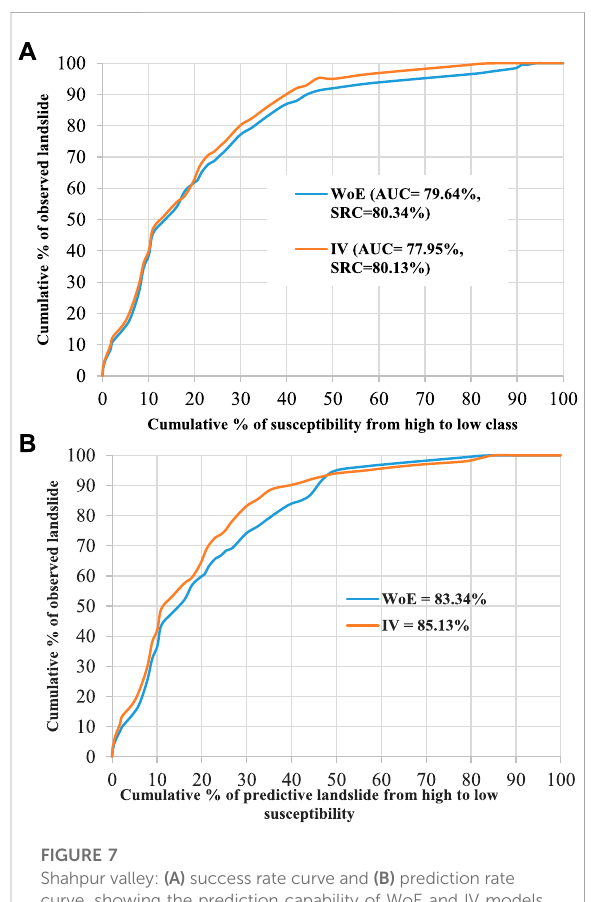
FIGURE 7 Shahpur valley: (A) success rate curve and (B) prediction rate curve, showing the prediction capability of WoE and IV